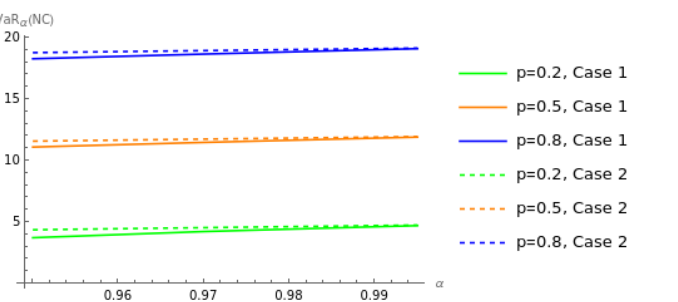
Figure 5. Effects of θ = 0 (no correlation between X and Y ) on VaR α ( NC; c ∗ , d ∗ , υ ∗ ) under the EVPP when p = 0.2,0.5,0.8.